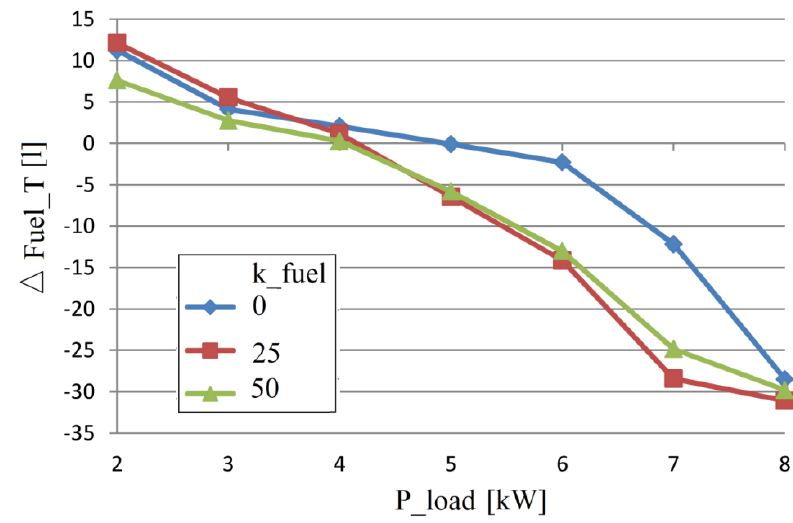
Figure 9. The values of the fuel economy, in the all situation, for the RTO3 strategy: A ( k fuel = 0), B ( k fuel = 25), and C ( k fuel = 50) under constant load.